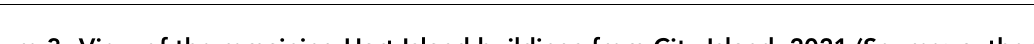
Figure 3. View of the remaining Hart Island buildings from City Island, 2021 (Source: